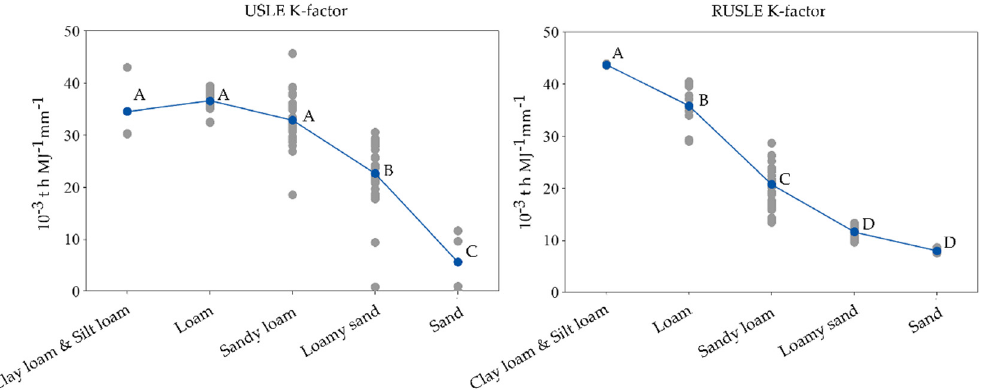
Figure 4. The individual value plots of the K-factors of the USLE and RUSLE models under different soil-texture classes from the study area. The gray dots represent the individual values, and the blue dots represent the mean. Same letter indicates the difference between the means is not statistically significant according to Tukey’s test.